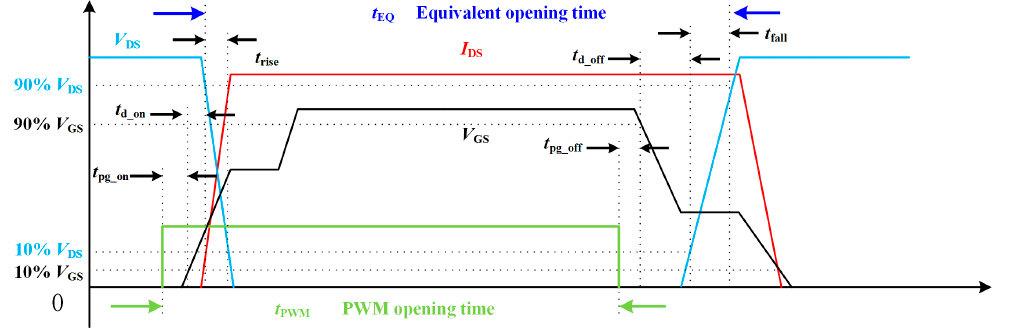
Figure 11. Waveforms of the switching operation. Table 1. The proportion of the deviation.